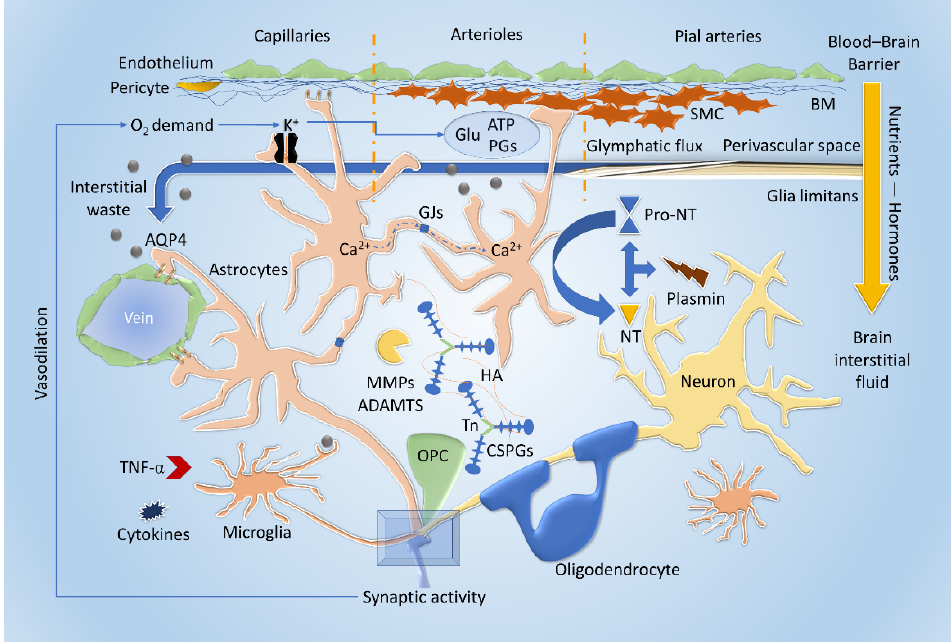
Figure 1. Metabolic coupling, extracellular signaling, and interstitial fluid dynamics. Synaptic activity regulates the release of K + and augments O 2 demand. These phenomena act directly on capillaries (endothelium and pericytes) and probably on astrocytes, increasing the blood flow particularly producing hyperpolarization to smooth muscle cells (SMC). These cells, relaxing, prompt vasodilation, which is also stimulated by direct gliotransmission that releases glutamate (Glu), ATP, and prostaglandins (PGs) with a Ca 2+ -mediated mechanism. The neurovascular coupling may also increase nutrient availability and hormones transport through the blood–brain barrier (BBB). The perivascular space from pial arterioles and tight-junction capillaries and their basal membrane (BM) are involved in convective fluxes (glymphatic) pathways that rely on astrocytic aquaporin-4 (AQP4) on astrocytic end-feet to clear interstitial wastes from the central nervous system (CNS) towards the perivascular venous side and subsequently dural lymphatics (not shown). Modifiers, such as matrix metalloproteinases (MMPs) and a disintegrin and metalloproteinase with thrombospondin motifs (ADAMTS), are produced by the different cellular elements, as for the chondroitin sulfate proteoglycans (CSPGs), tenascin (Tn), and hyaluronic acid (HA). The neurotrophins (NT) levels can be modified by the MMPs, by the neuronal plasmin, and astrocytic re-uptake, cleaving their pro-form (pro-NT) or degrading the mature protein. Microglial cells also contribute to NT secretion and tumor necrosis factor α (TNF α ) and cytokines production to fulfill their role of innate immunity element while scanning the environment for molecular wastes. Oligodendrocytes and their precursors (OPC) are not only indispensable for myelination but are associated with learning and also contribute to the maintenance of the ECM.